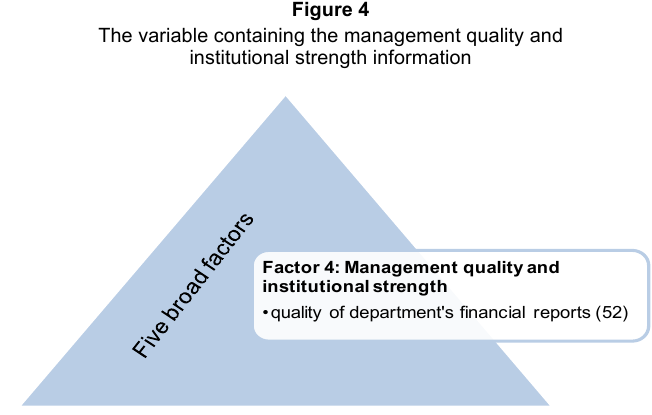
The variable containing the management quality and institutional strength information